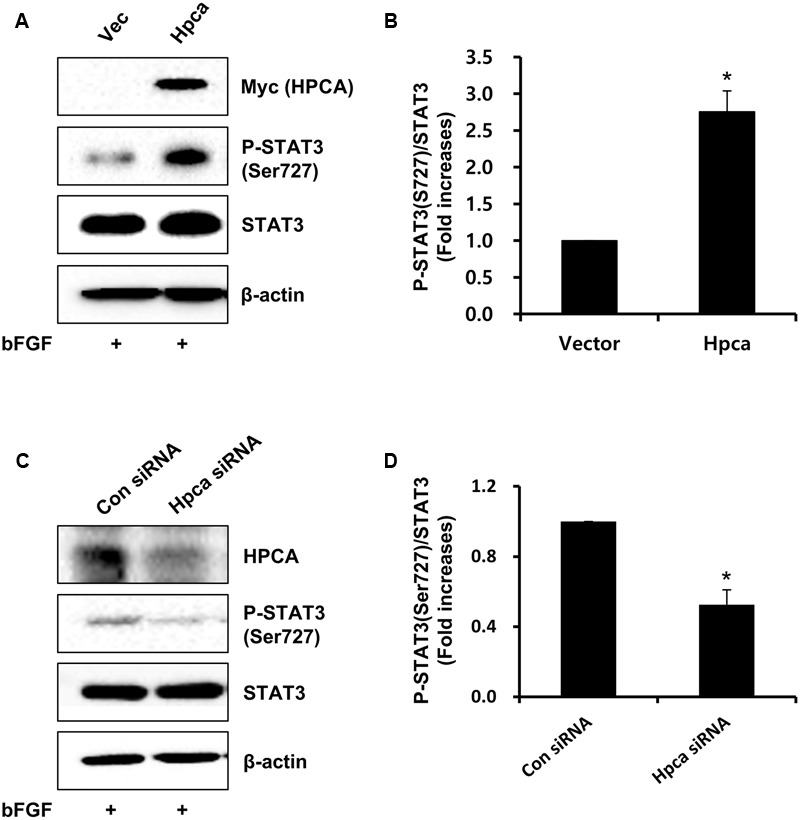
Effect of Hpca on STAT3 (Ser727) activation in HNPCs. (A) HNPCs were transfected with pMSCV-IRES-EGFP or pMSCV-Hpca-myc-IRES-EGFP for 48 h in the presence of bFGF. Proteins were analyzed by western blotting with anti-Myc, anti-p-STAT3 (Ser727), anti-STAT3, and anti-β-actin. (B) Graph shows mean densities as fold increases in three independent experiments (means ± SD). Band intensities were quantified with Quantity Ones® software. ∗p < 0.001 compared with the vector control. (C) Cells were transfected with control siRNA or Hpca siRNA for 72 h. Cell were lysed and analyzed by western blotting with anti-hippocalcin, anti-p-STAT3 (Ser727), anti-STAT3, and anti-β-actin. (D) Graph shows mean densities as fold increases from three independent experiments (means ± SD). ∗p < 0.001 compared with the +bFGF/control siRNA.